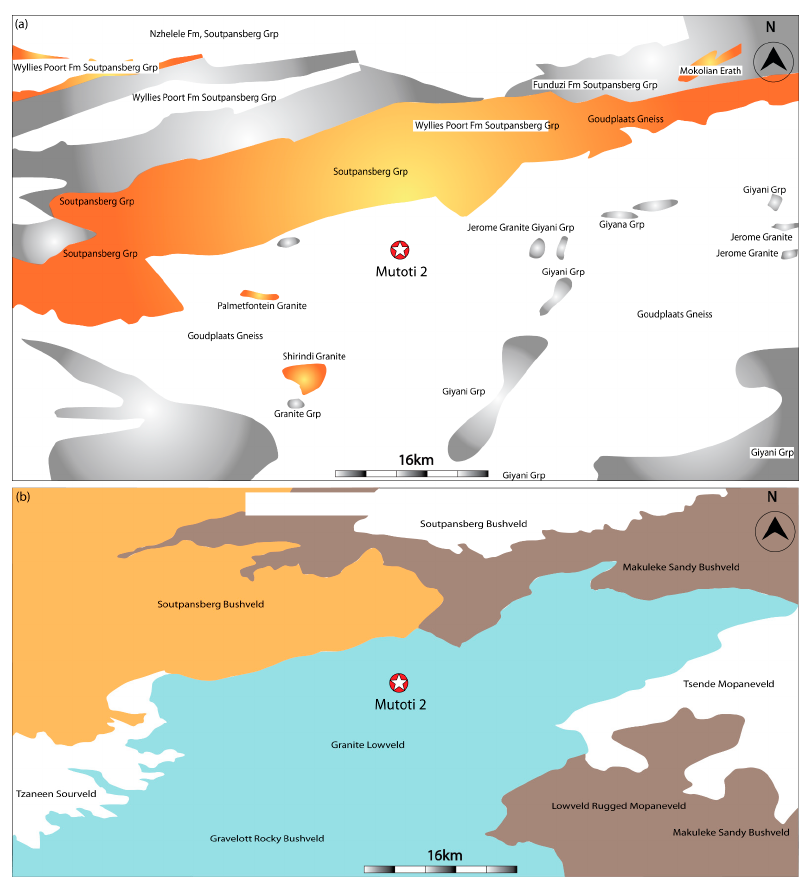
Figure 2. The geology ( a ) and vegetation ( b ) around the Early Iron Age of Mutoti 2. The rescue work carried out at Mutoti 2 identified significant iron production re- mains comprised of tuyeres, collapsed furnace remains, and ubiquitous amounts of slag in contexts associated with remnant settlement structures, features, and midden debris covering 18,000 sq metres of residential space. Other remains included 40 grain bins, un- derground storage pits, animal bone, EIA potsherds, two fragments of brown- and blue- glazed pre-Islamic wares from the Middle East, and 23 house foundations with gravel floors and dhaka walls with pole impressions. The local pottery includes features of the Urewe and Kalundu EIA traditions [4]. Available radiocarbon data suggests that Mutoti